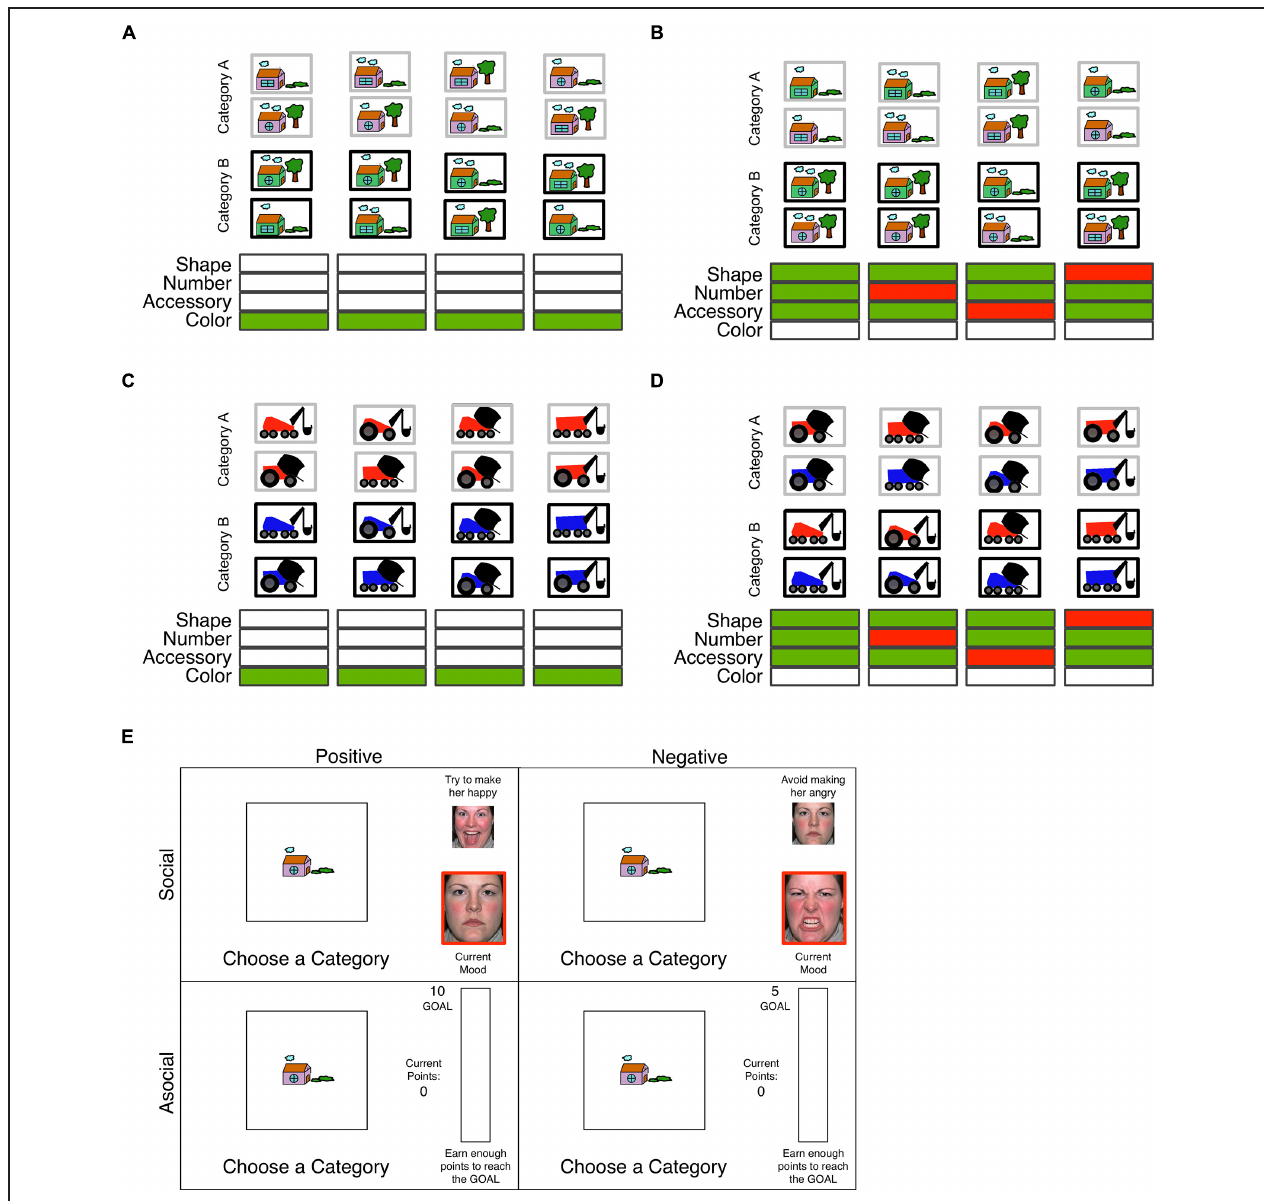
FIGURE 2 | Example surface features (houses, vehicles) with an example of category membership for the rule-based (A,C; rule = color) and information integration (B,D; rule = shape (window, body), number (cloud, wheel) accessory (landscape, tool); see Materials and Methods) tasks. Features disambiguating category